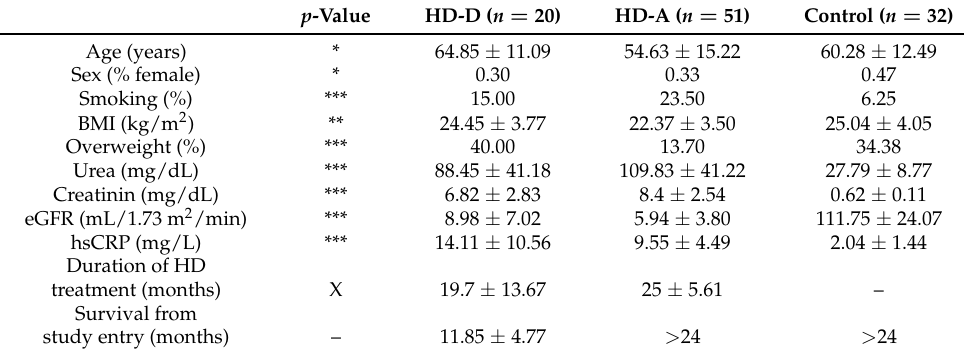
Table 1. Basic information about the groups (MEAN ± SD or % in the case of Sex, Smoking, and Overweight). Statistical significance given in respective columns was calculated based on the χ 2 test for data on Sex, Smoking, and Overweight. In the remaining cases, the p -value was taken from the results of the Kruskal–Wallis H test. Since the group HD-D in contrast to HD-A and Control contains only patients who died, there was no point in calculating the p -value for survival from study entry. The comparison of the duration of HD treatment took into account only two groups (HD-A and HD-D). Significance of differences found is marked in following way: ***— p ≤ 0.001;